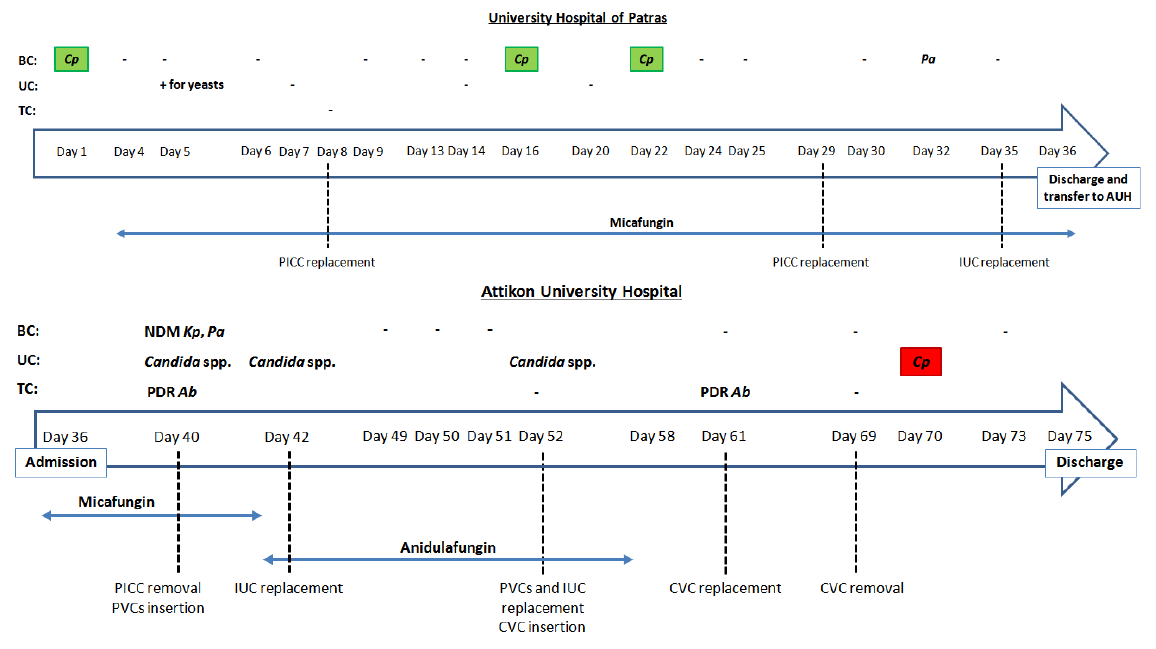
Figure 1. Timeline of microbiological investigation and antifungal therapy. Echinocandin-susceptible and echinocandin-resistant C. parapsilosis isolates are shaded in green and red, respectively. BC: blood culture; UC: urine culture; TC: tip culture; Cp : C. parapsilosis ; Pa : Pseudomonas aeruginosa ; Kp : Klebsiella pneumoniae ; NDM: New Delhi metallo- β -lactamase; Ab : Acinetobacter baumannii ; PDR: pan-drug-resistant; PICC: peripherally inserted central catheter; PVC: peripheral venous catheter; CVC: central venous catheter; IUC: indwelling urinary catheter.